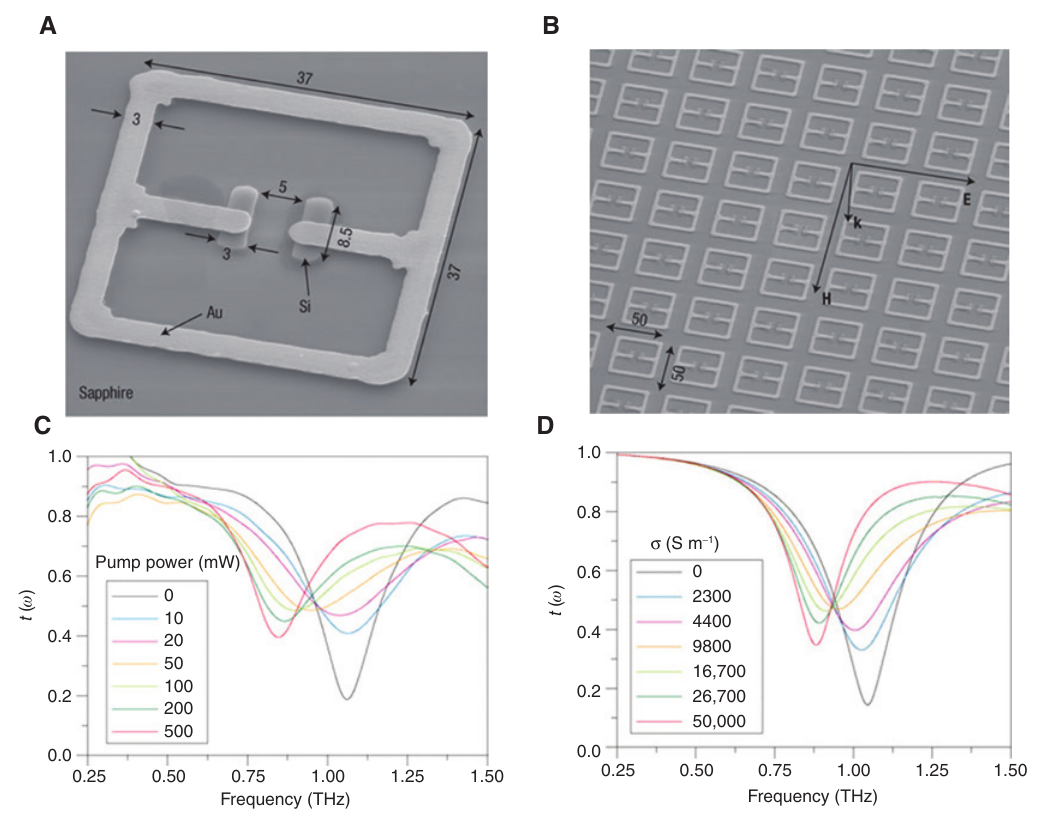
Figure 2: (A and B) SEM images of the single metallic/silicon SRR and an array. (C) The experimental frequency tuning achieved at different pumping levels and (D) the corresponding simulations. Figure adapted with permission from Macmillan Publishers Ltd.: Nature Photonics [48]. Copyright